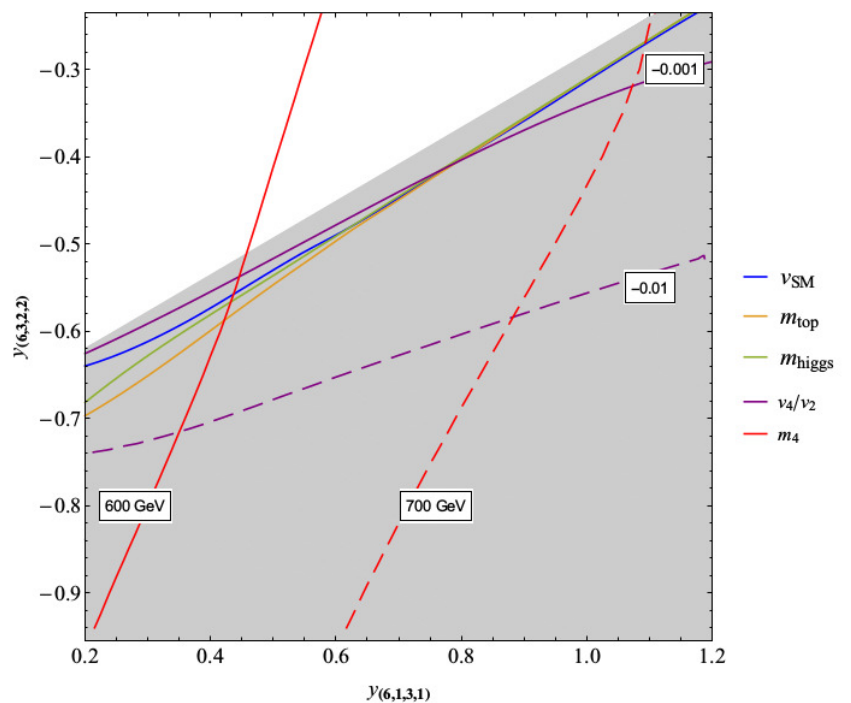
Figure 2 . In gray and white we show the regions with and without EWSB in the plane y y , with the other parameters (cid:12)xed by the benchmark point described in eq. (4.15). In the plot ( 6 ; 3 ; 2 ; 2 ) (cid:24) increases from zero in the white region, to (cid:24) 0 : 41 in the down-right corner, with v SM = 246 GeV along the blue line. In the orange and green lines m t ’ 150 GeV and m h ’ 125 GeV, respectively. The violet lines indicate constant values of v 4 =v , whereas the red ones show constant values of m H 4